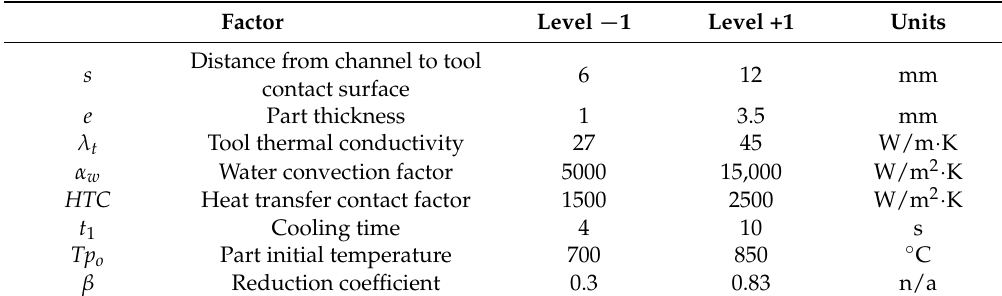
Table 4. Values of the design of experiments (DOE) factors.